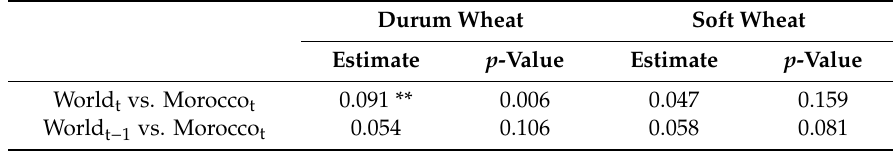
Table 6. Pearson’s correlation coe ffi